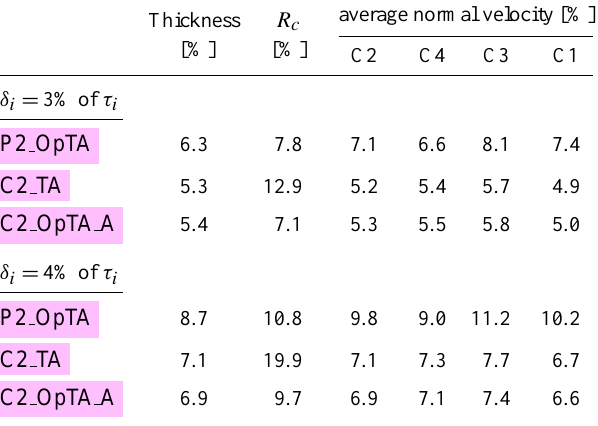
Table C1. The relative standard deviation of the MP thickness, radius of curvature, and average normal velocities at each space- craft, arising from the timing information inaccuracy. Results corre- sponding to three solutions are presented, i.e. C2 OpTA A , C2 TA , and P2 OpTA , for two sets of values of the parameters δ i , measur- ing the timing information inaccuracy (see text for more explana-